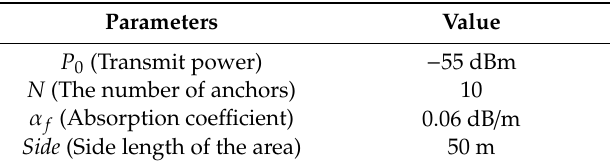
Table 4. Parameters in the scenario with variable σ 2